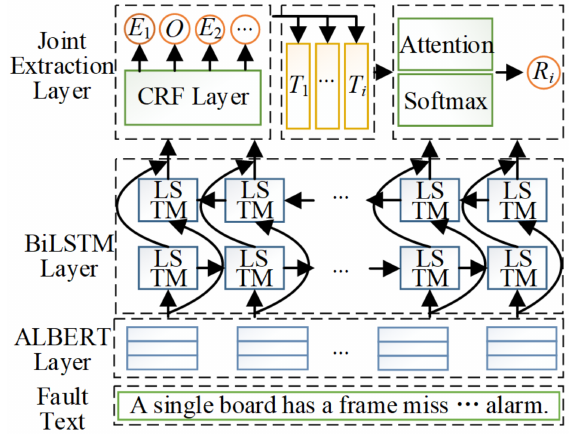
Figure 6. Multi-entity knowledge joint extraction framework diagram.